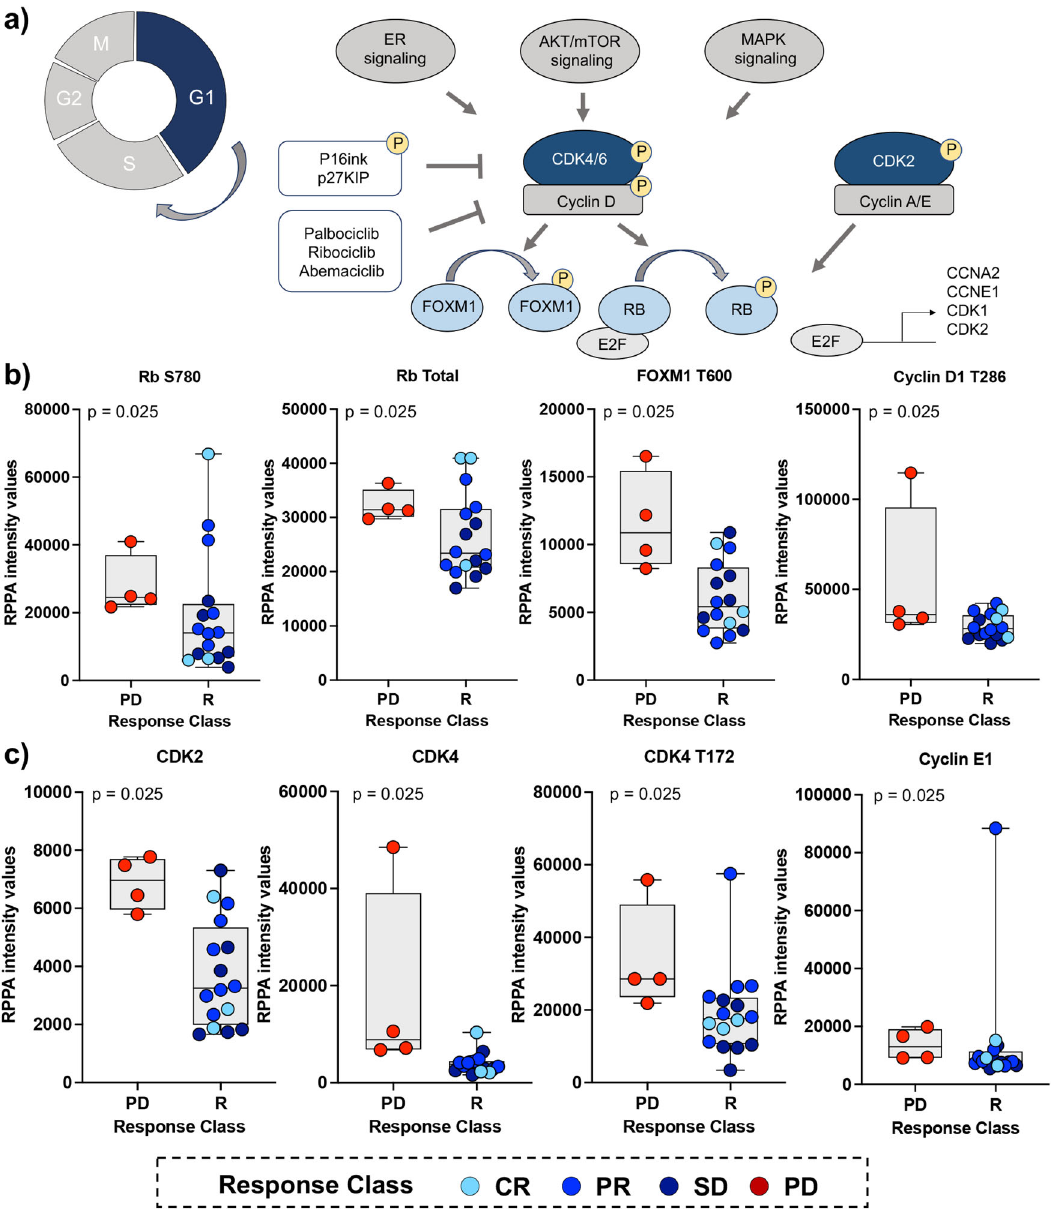
Fig. 1 Expression and phosphorylation levels of CDK4/6 downstream substrates and regulators correlate with response to fi rst-line treatment with ET plus CDK4/6 inhibition in MBC patients. Diagram showing functional interactions between CDK4/6 and its downstream substrates ( a ). Box plots with median (center line) and maximum and minimum values (whiskers) show RPPA-based expression and activation levels of CDKs, cyclins, and their downstream substrates. RPPA-based expression and/or phosphorylation of key functional residues of three qualifying biomarkers was signi fi cantly higher in patients with progressive disease (PD) compared to responders (R) ( b ). A statistically signi fi cant increase in the expression and activation of signaling molecules involved in Rb regulation was also detected in patients with progressive disease compared to responders ( c ); p values for two-sided chi-square tests for dichotomized levels of measured biomarkers (above/below the population median) are shown. Samples are color-coded based on patient